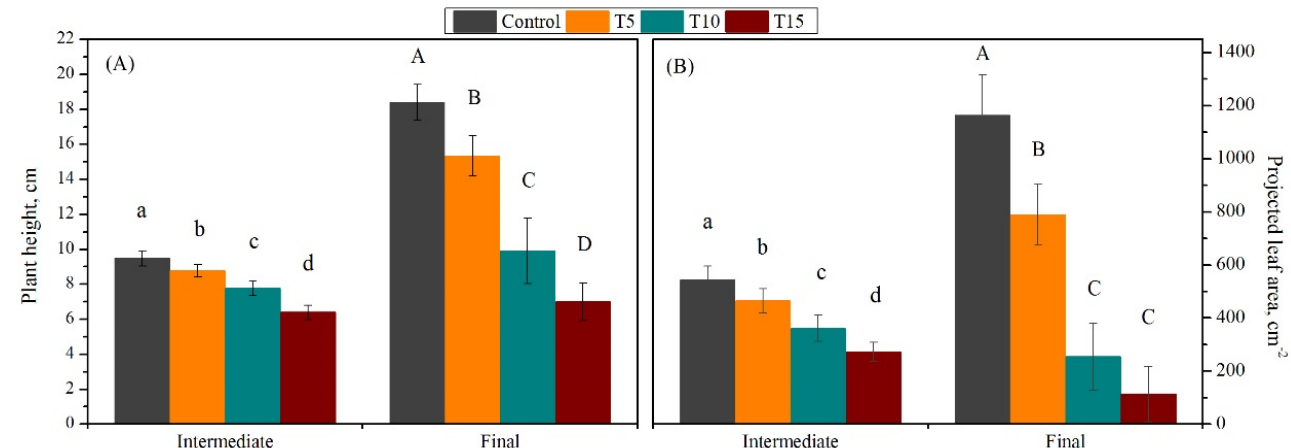
Figure 1. Growth characteristics of basil leaves grown under the various salinity treatments: plant height at the intermediate and final harvests ( A ); projected leaf area at the intermediate and final harvests ( B ). Values are expressed as mean ± standard deviation ( n = 50 for plant height and n = 10 for the PLA). Different letters indicate statistically significant differences between treatments at each harvest (small letters refer to the intermediate and capital ones to the final harvest, p < 0.05).